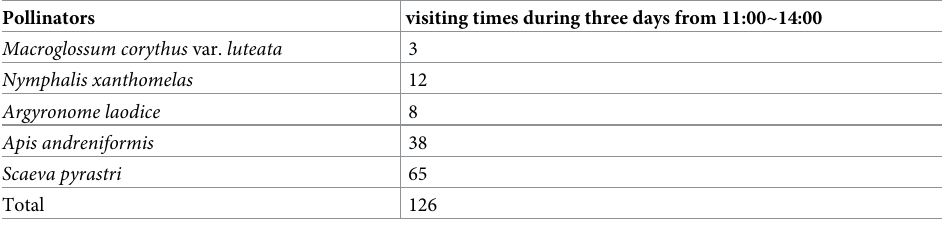
Table 6. Pollinators and visiting times during 3 days from 11:00 to 14:00. Pollinators